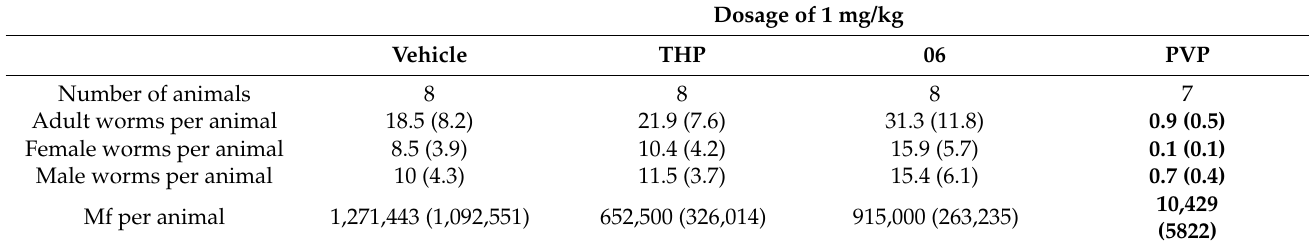
Table 3. Treatment with PVP reduces adult worm burden and mf levels in the peritoneal cavity. The mean number of adult worms and mf from animals given 1 mg/kg PVP IP was reduced by 20- and 100-fold, respectively, compared to vehicle treated animals. Means ± SEM (in parentheses) are